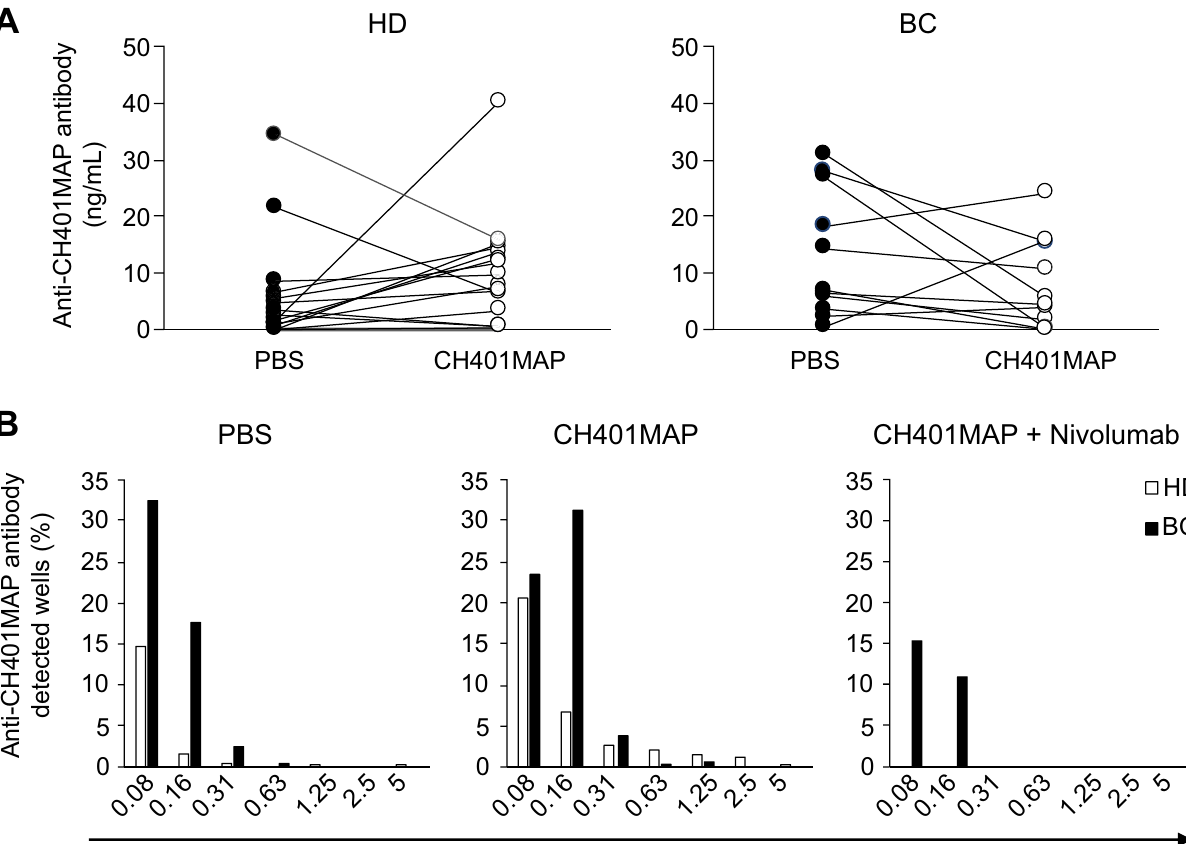
Figure 4. Production of specific antibody was decreased in BC immune environment. Concentrations of anti- CH401MAP antibody in plasma of HD-M and BC-M. (A) Transition graph of anti-CH401MAP antibody in mice transplanted with PBMCs of HD ( n = 17) or BC ( n = 12). The concentration was compared between PBS (filled circle) or CH401MAP (open circle) groups, and the lines represent the mice transplanted with the same donor PBMC. (B) Anti-CH401MAP antibody concentration in supernatant and percentage of anti-CH401MAP antibody detected in wells in a culture plate. HD- or BC-transplanted spleens were fused with P3X ( n = 5). As the hybridoma yield is different between each experiment, positive cell ratio was calculated based on the sum of all experiments. BC breast cancer; HD healthy donor; PBMCs peripheral blood mononuclear cells; PBS phosphate-buffered